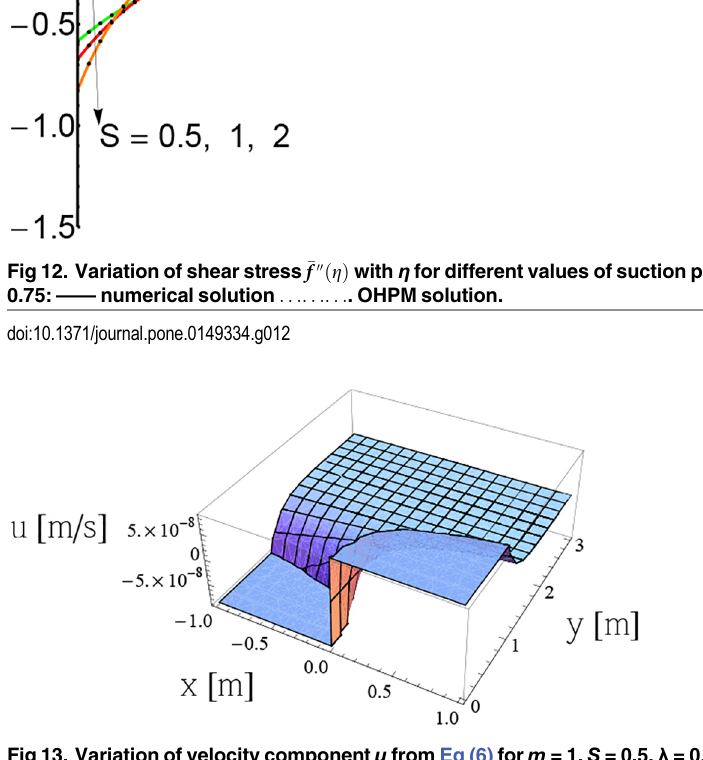
PLOS ONE | DOI:10.1371/journal.pone.0149334 March 31,